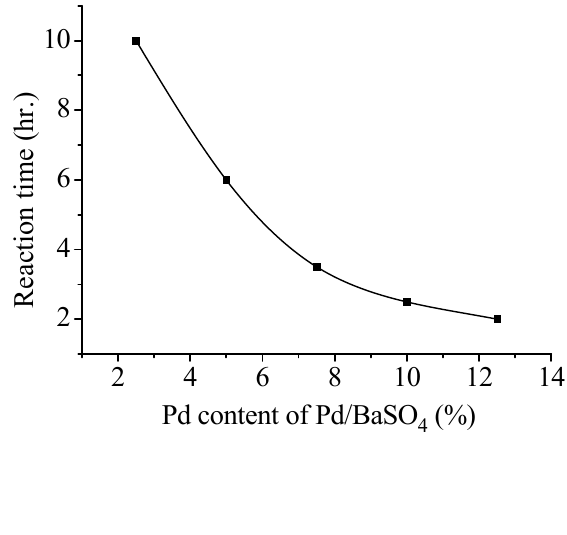
Figure 3. Effect of Pd content on reaction